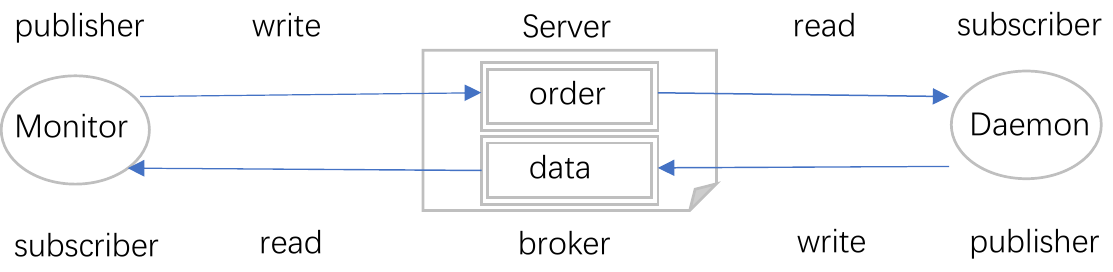
Figure 9. Interaction between the monitor and daemon.